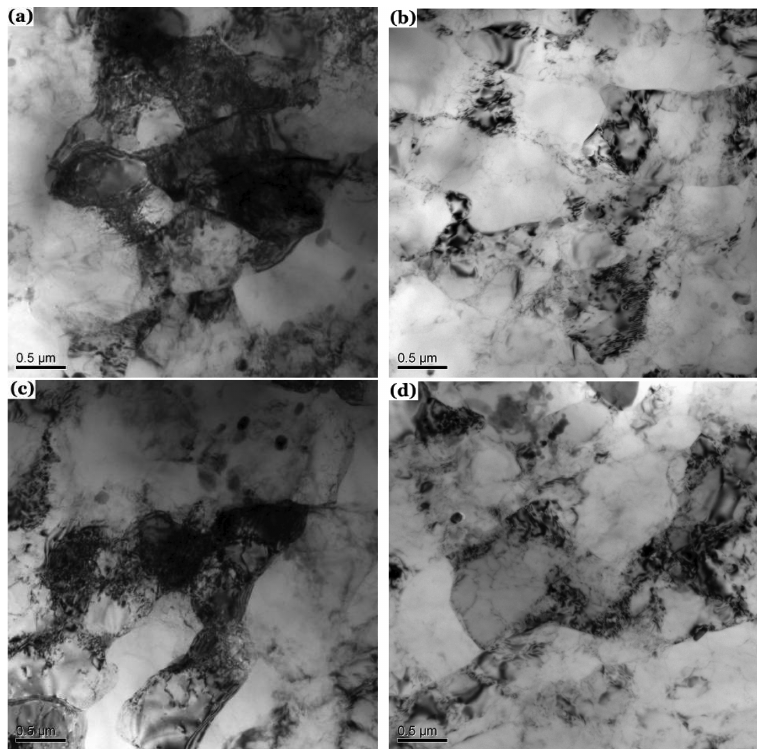
boundary was bending after compression deformation, and a large number of dislocation was assembled at the grain boundary. Figure 6(d) represented the subgrain structure and the equiaxial grain structure was forming